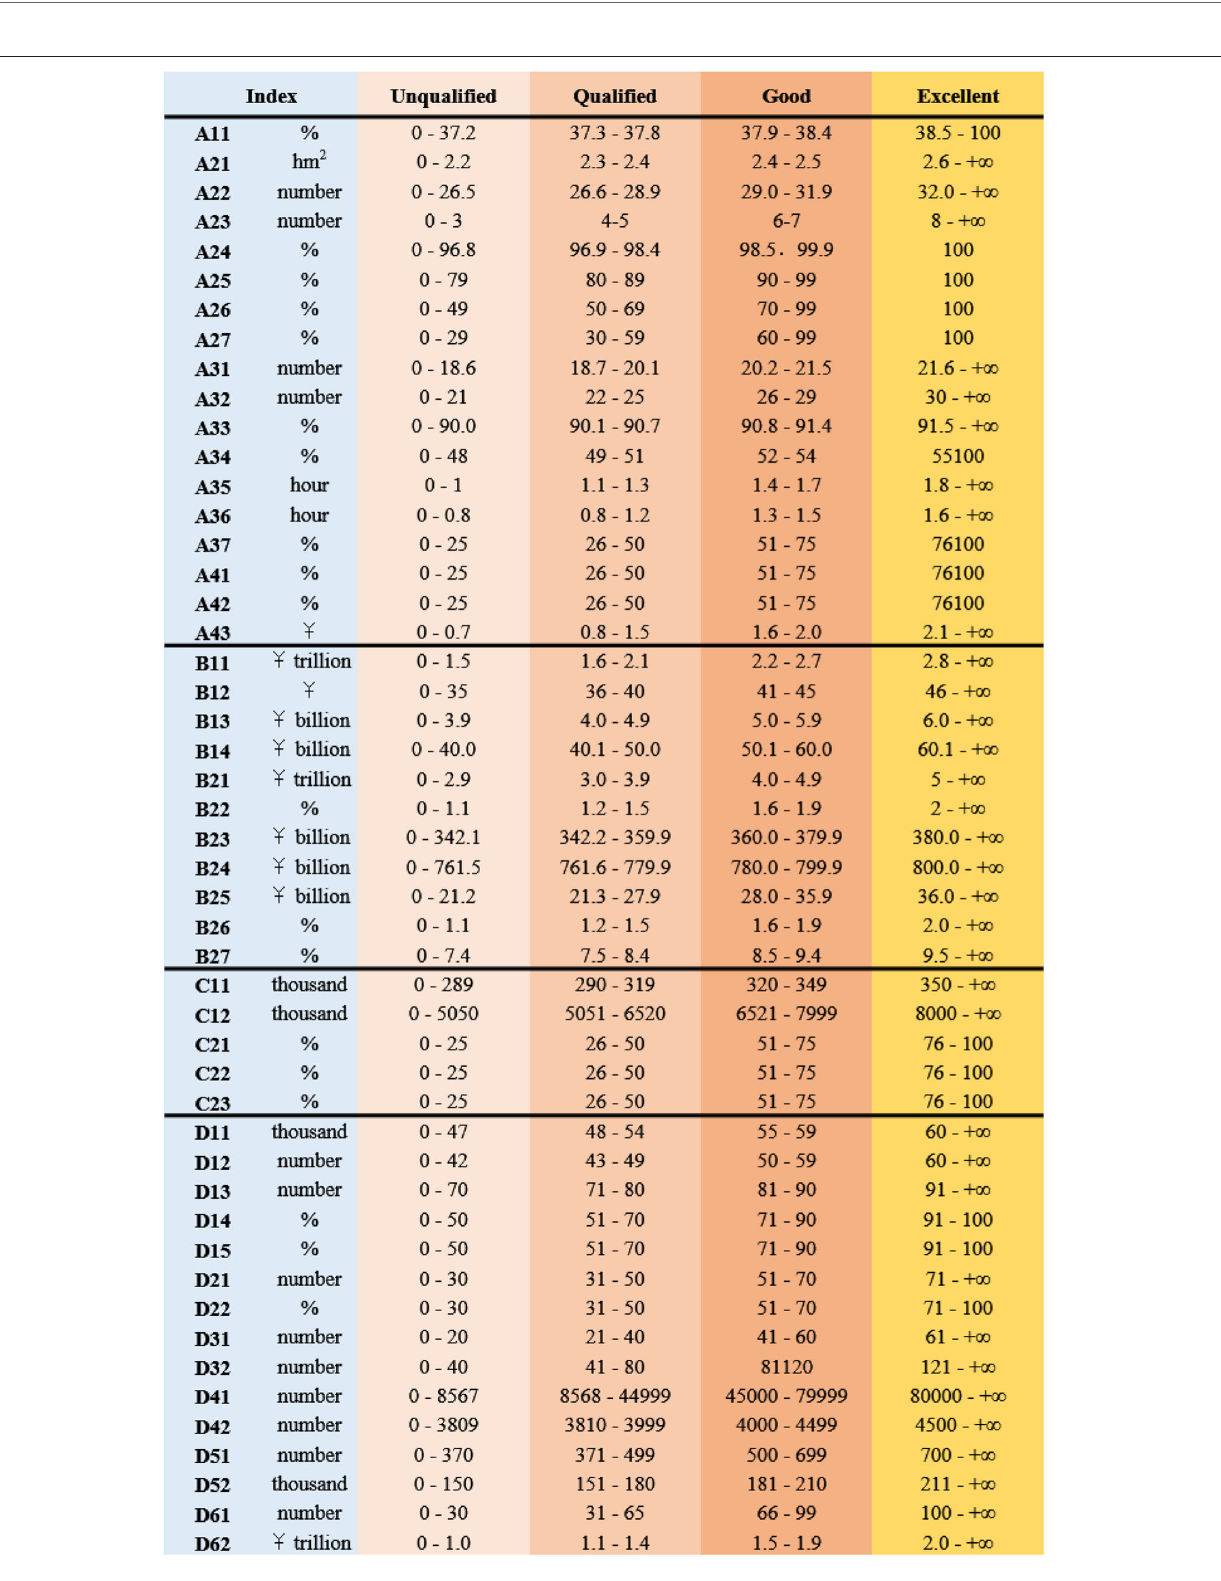
FIGURE 3 | National fitness assessment index interval reference standard table.